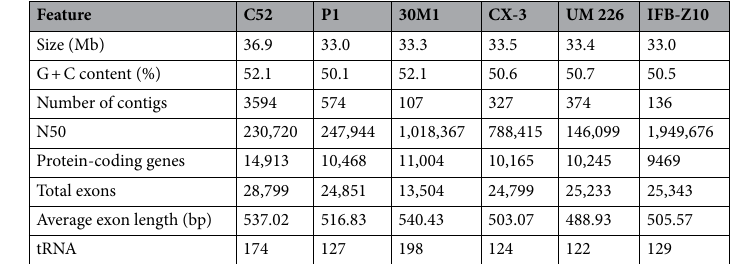
Table 1. Comparison of genome features between C. eragrostidis C52 and closely related Curvularia species. *C52, C. eragrostidis C52; P1, C. geniculata P1; 30M1, C. kusanoi 30M1; CX-3, C. lunata CX-3; UM 226, C. papendorfii UM 226; IFB-Z10, Curvularia sp. IFB-Z10.